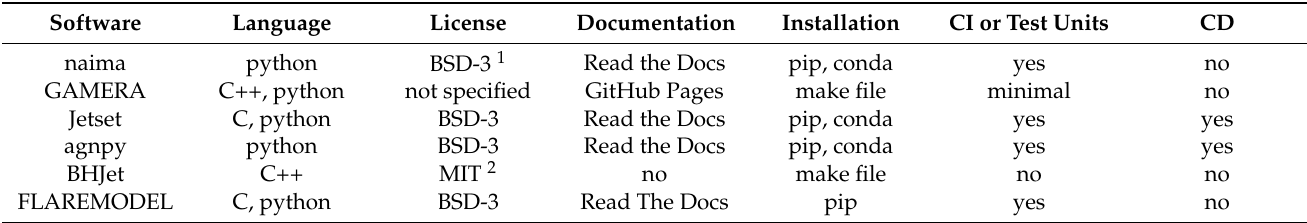
Table 2. Compliance of software reviewed with modern good software